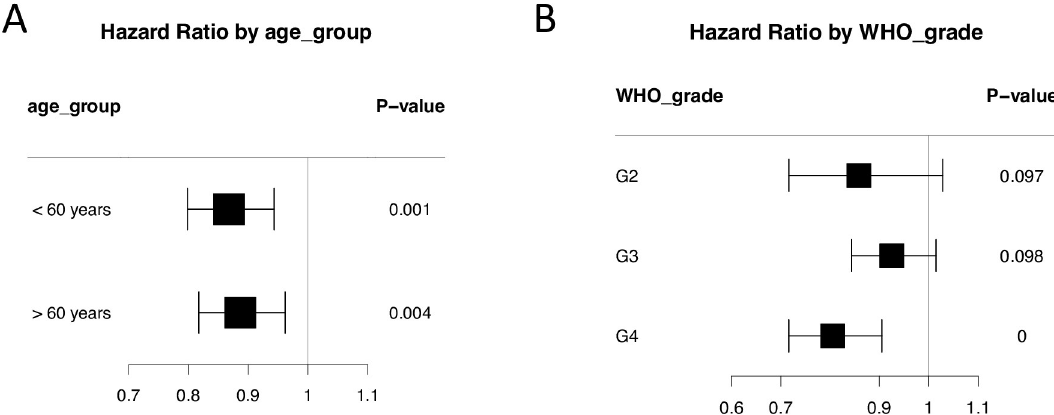
Fig 2. Forest plot shows associations of age acceleration with patient overall survival in stratified patient groups: (A) Age group; (B) Tumor grade.